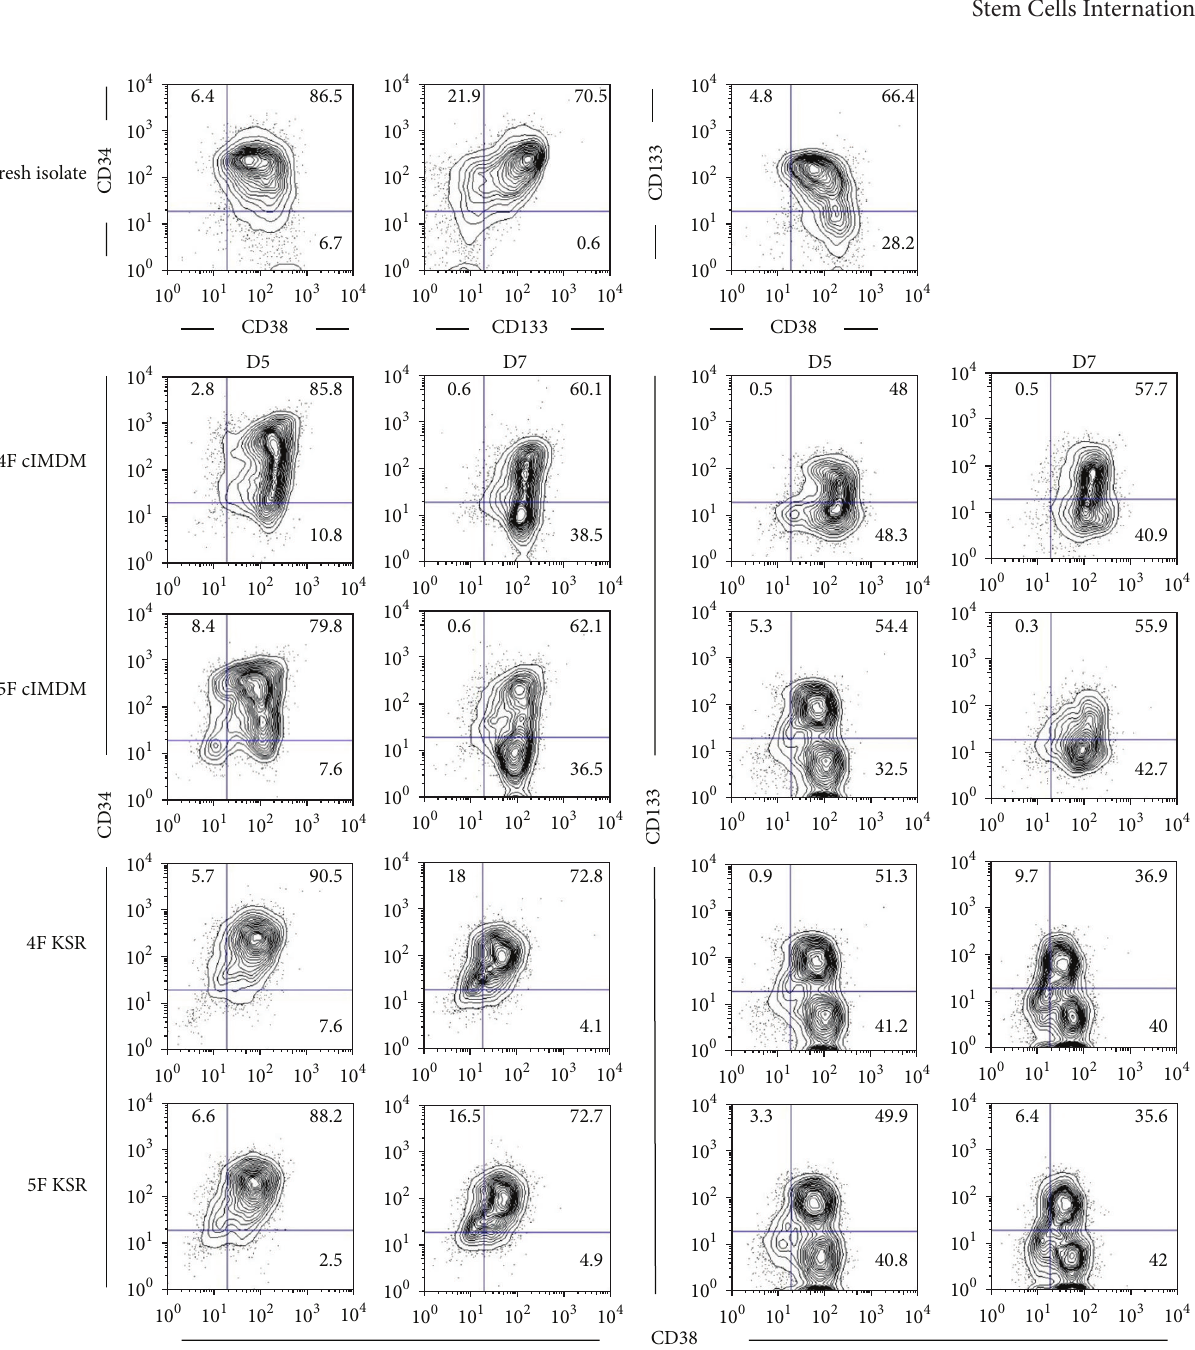
Figure 2: Immunophenotype of expanded cells. Representative cell surface markers CD34/CD38/CD133 of fresh isolated CD34 + cells and expanded cells at 5 and 7 days of each culture